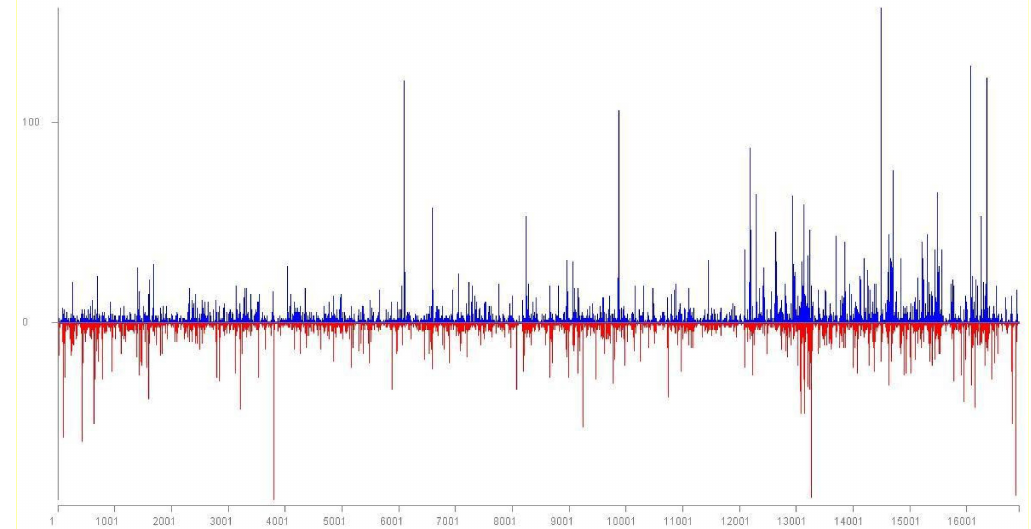
Figure 1. Location and frequency of Little cherry virus 1 (LChV1) small RNA reads on the LChV1 genomic RNA. Positive-sense reads are shown as blue bars; negative-sense reads are shown as red bars below the x-axis.